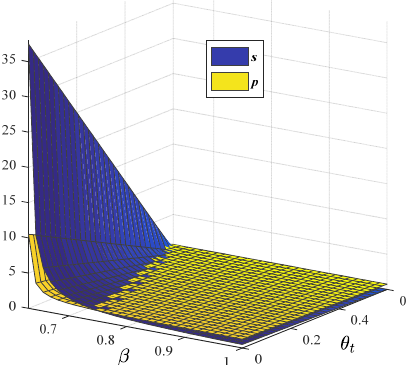
Figure 15. Price and service in Scenario D (4).